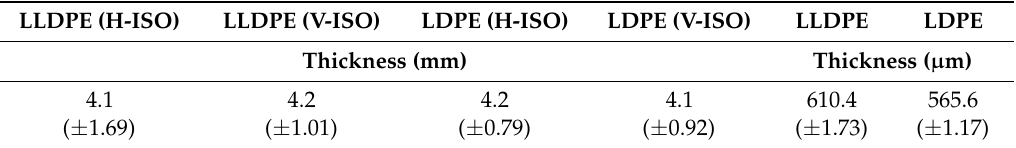
Table 4. Thickness data mean obtained on ISO 527 specimens and dog-bone shaped specimens made of linear low-density polyethylene (LLDPE) and low-density polyethylene (LDPE) expressed as a mean ± % standard deviation.